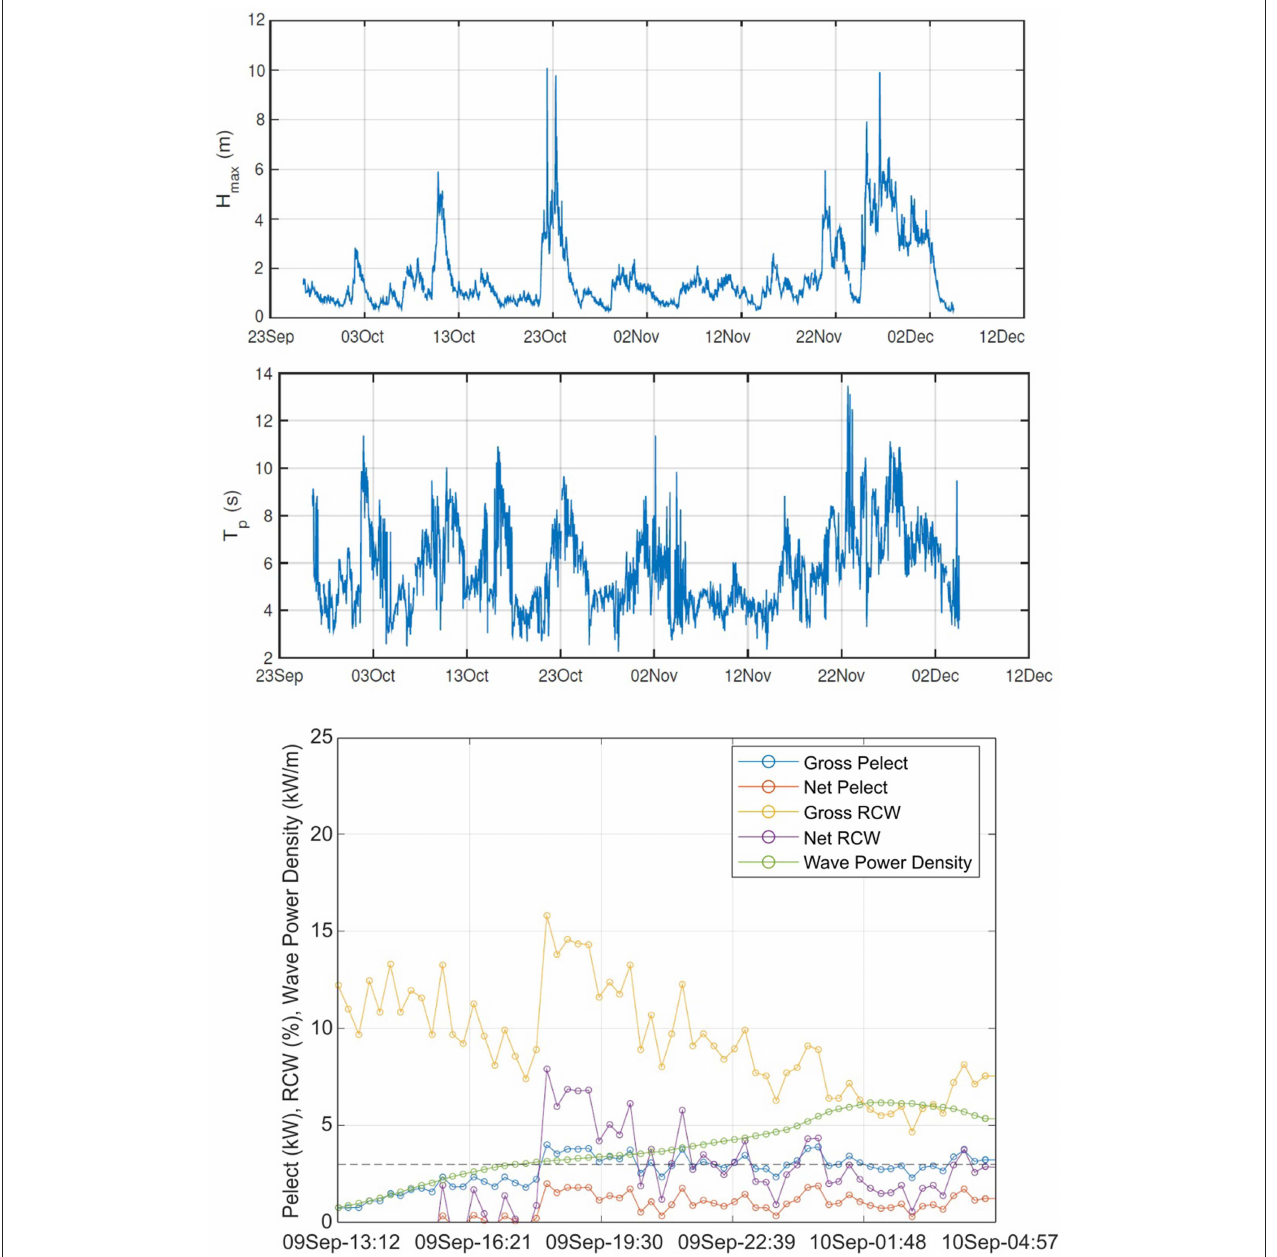
FIGURE 15 | Historical data of sea states encountered between September and December 2015 (Top) , experimental performance of ISWEC in Pantelleria (Bottom)